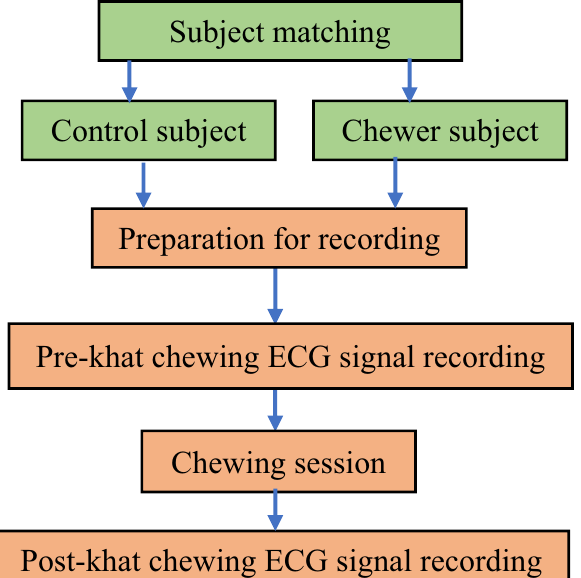
Figure 2. ECG data acquisition procedure to investigate the effect of khat chewing on heart